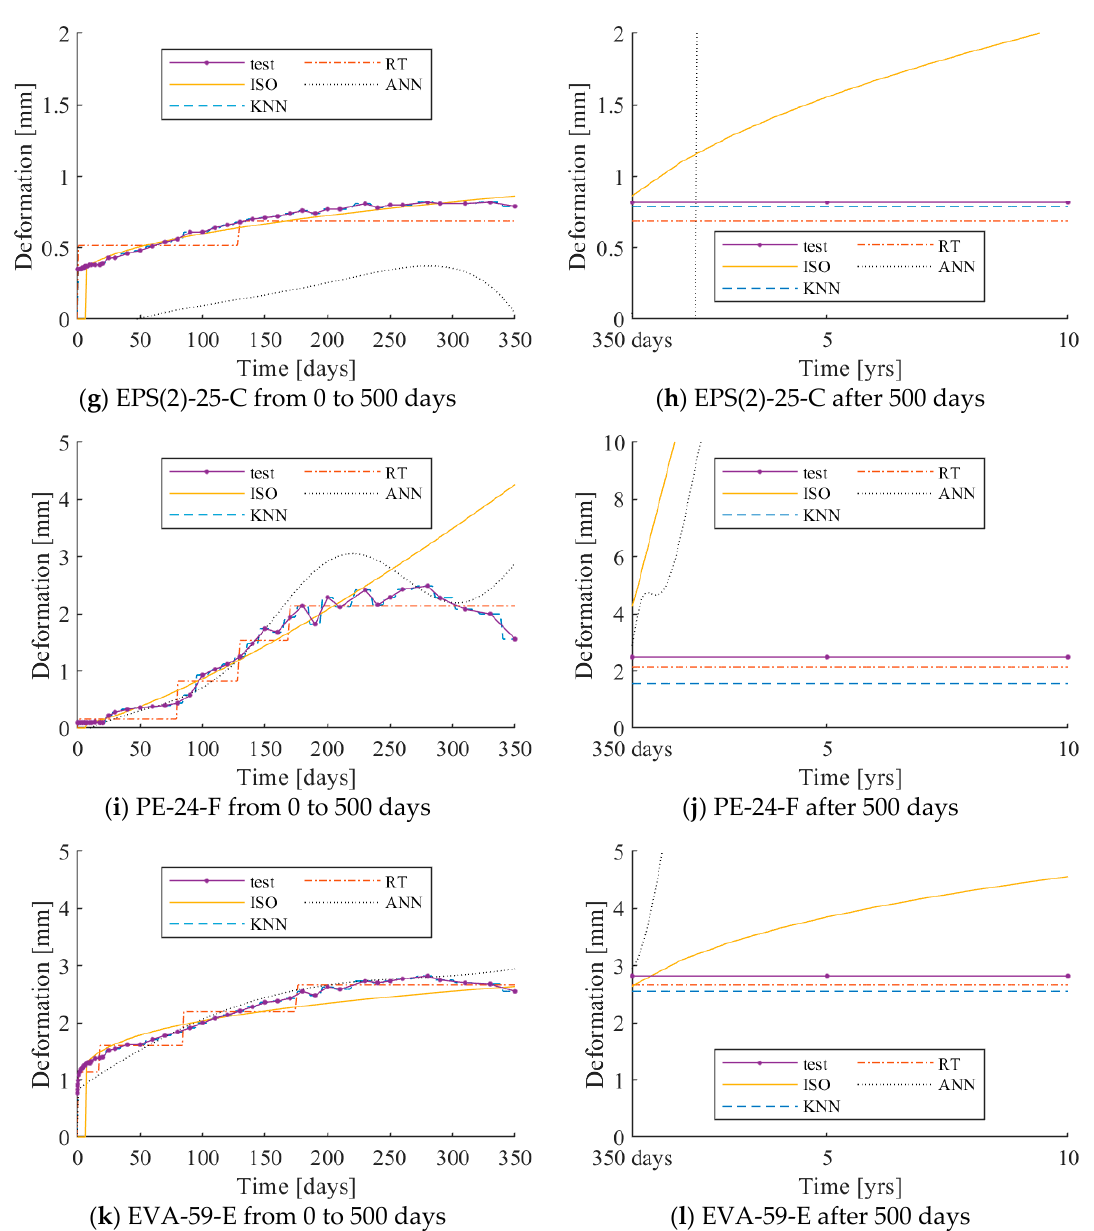
Figure A1. Long-term deformations as predicted by ISO 20392 (solid), KNN (dashed), RT (dash-dot), and ANN (dotted) compared to the experimental data under 40 N loading.